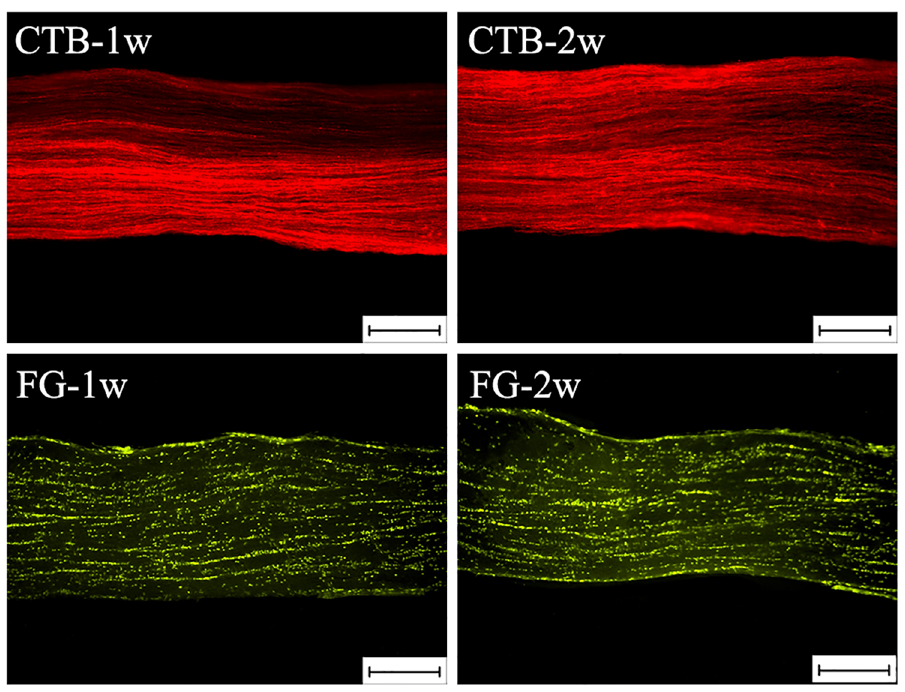
Fig 4. The characteristics of optic nerves retrograde labeled using cholera toxin subunit B (CTB) and Fluorogold (FG) at 1 week and 2 weeks in rats. The optic nerves labeled using CTB were much clearer than those labeled using FG. CTB-1w, rats euthanized 1 week post-CTB injection; CTB-2w, rats euthanized 2 weeks post-CTB injection; FG- 1w, rats euthanized 1 week post-FG injection; FG-2w, rats euthanized 2 weeks post-FG injection. Scale bar = 200 μ